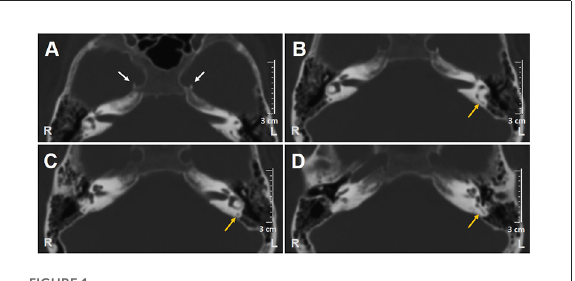
FIGURE1 Axial scans of brain CT show (A) bilateral carotid siphon calcifications (white arrows) and (B–D) patent left PSC (yellow arrows). CT, computed tomography; L, left; PSC, posterior semicircular canal; R,